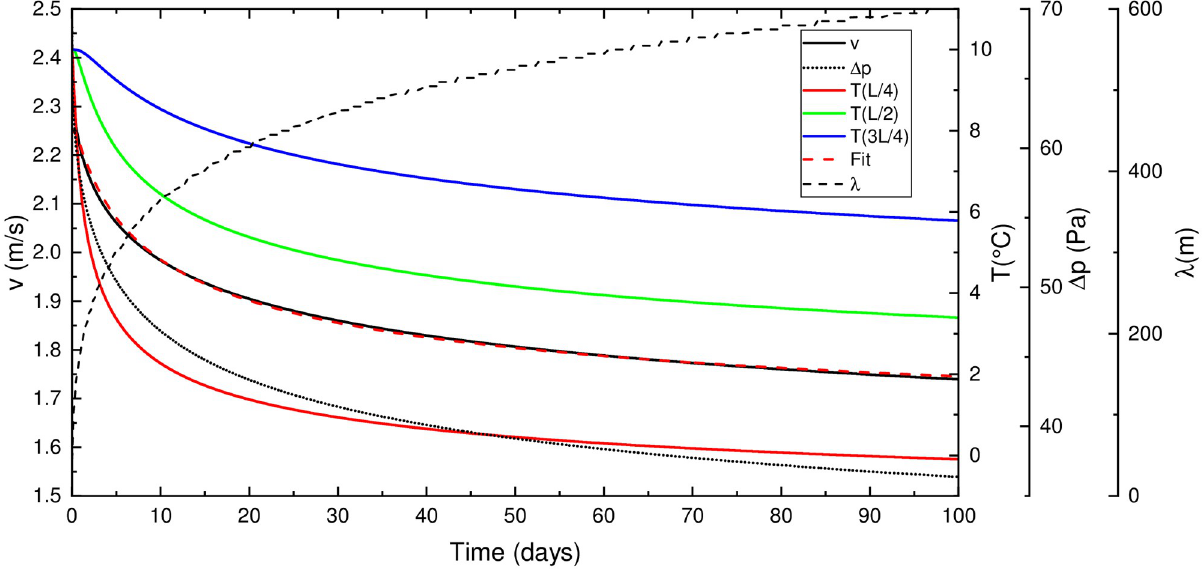
Fig 6. Airflow velocity, driving pressure, relaxation length and temperature at three different locations in the tube for the case with the constant outside temperature at T out = −